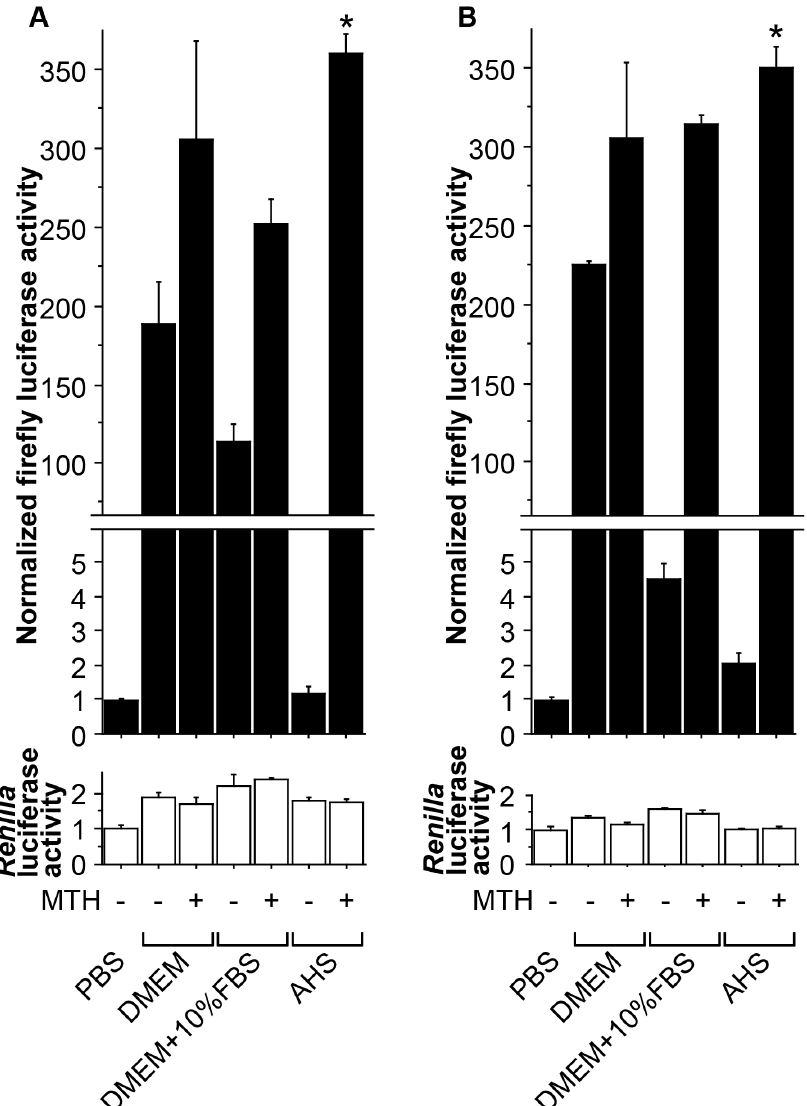
Figure 2. MTH-induced AhR activation in different environments. HepG2-XRE cells were incubated for 4 h in each medium, with 80 m M MTH (‘‘MTH + ’’) or 0.1% (v/v) DMSO (‘‘MTH 2 ’’). ( A ) and ( B ) were performed using the same materials and protocol, at different times. Renilla luciferase activity is presented for the same purpose as in Fig. 1. Error bars denote SDs for triplicate wells. Asterisks indicate significantly ( p , 0.05) higher normalized firefly luciferase activity than that in cells placed in PBS without MTH treatment (1 st column). The mean values for the 1 st column were defined as 1.0.